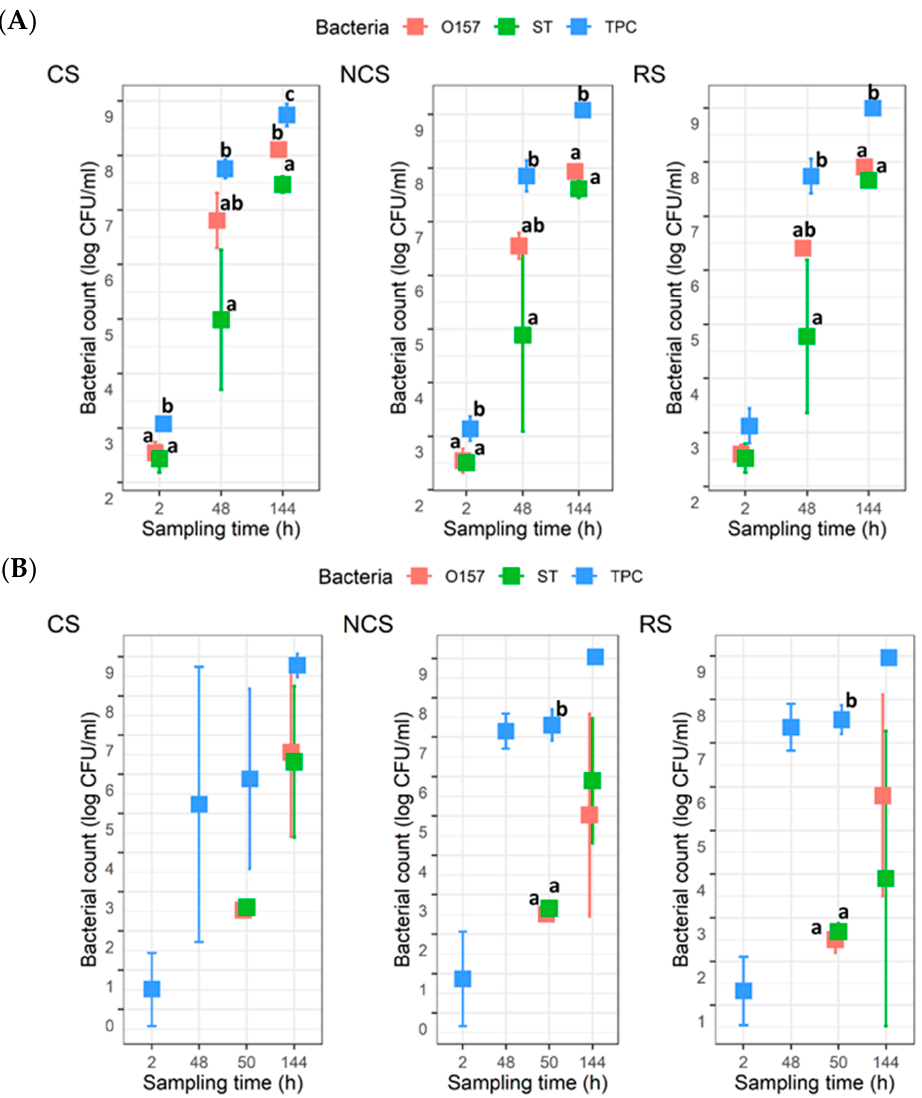
Figure 2. Total plate count (TPC), Escherichia coli O157:H7 (O157), and Salmonella Typhimurium (ST) counts in planktonic cultures (n = 3). Mixed cultures of the two pathogens and meat processing surface bacteria (MPB) in Lennox broth without salt were incubated at 15 °C for six days. O157 and ST were introduced simultaneously with MPB ( A ) or delayed by 48 h ( B ). MPBs were from the contact surfaces (CS), non-contact surfaces (NCS), and roller surfaces (RS) of the main conveyor belt on the fabrication floor of a beef processing facility. ANOVA was performed to compare the bacterial counts at each sampling time followed by a Sidak post hoc pairwise comparison. Significant ( p < 0.05) differences are indicated by different lowercase letters.